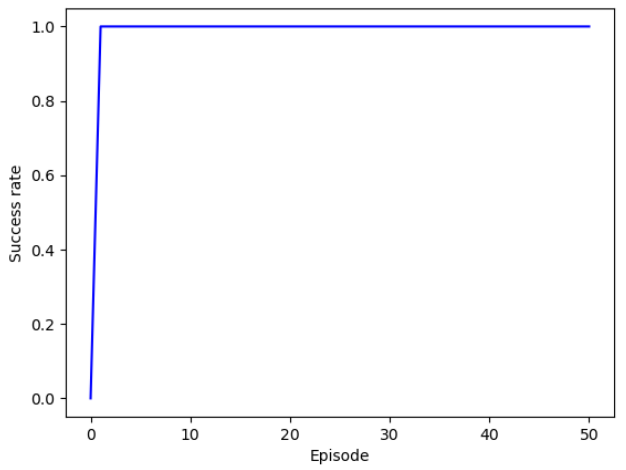
Figure 16. Experiment: success rate of the proposed path planning in